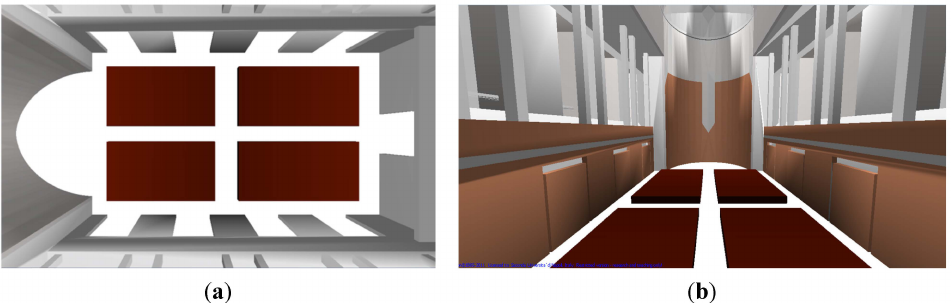
Figure 6. Plan distribution of the location of the audience ( a ), and position of banner treatments on the sides and in the apse ( b